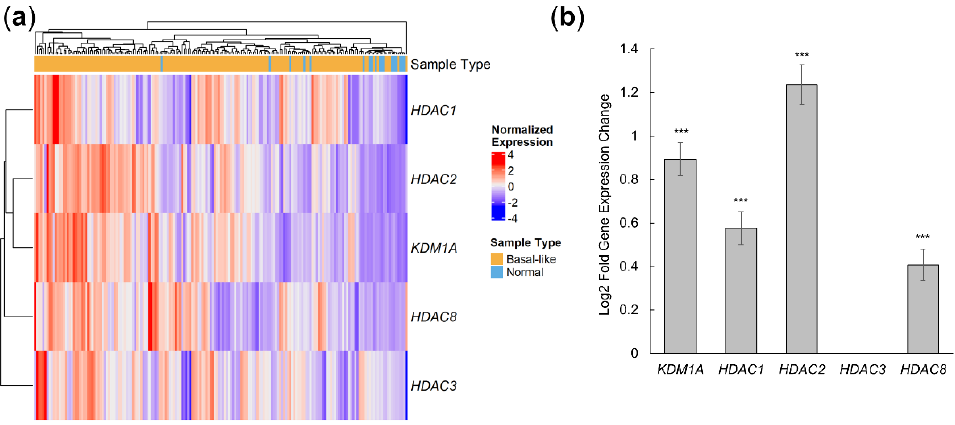
Figure 1. 4SC-202 targets are upregulated in human basal-like breast cancer tumors relative to normal tissue. Genomic Data Commons RNA-seq data for normal breast tissue ( n = 18) and basal-like breast tumor tissue ( n = 165) were analyzed for differential expression using DESeq2. ( a ) Heatmap of row z-scores for variance-stabilized gene expression values across normal and basal-like samples. Sample type is annotated at the top. ( b ) Log2 fold expression changes of basal-like tumors versus normal breast tissue. Error bars indicate the standard error of the mean of the log fold change; FDR < 0.001 (***).